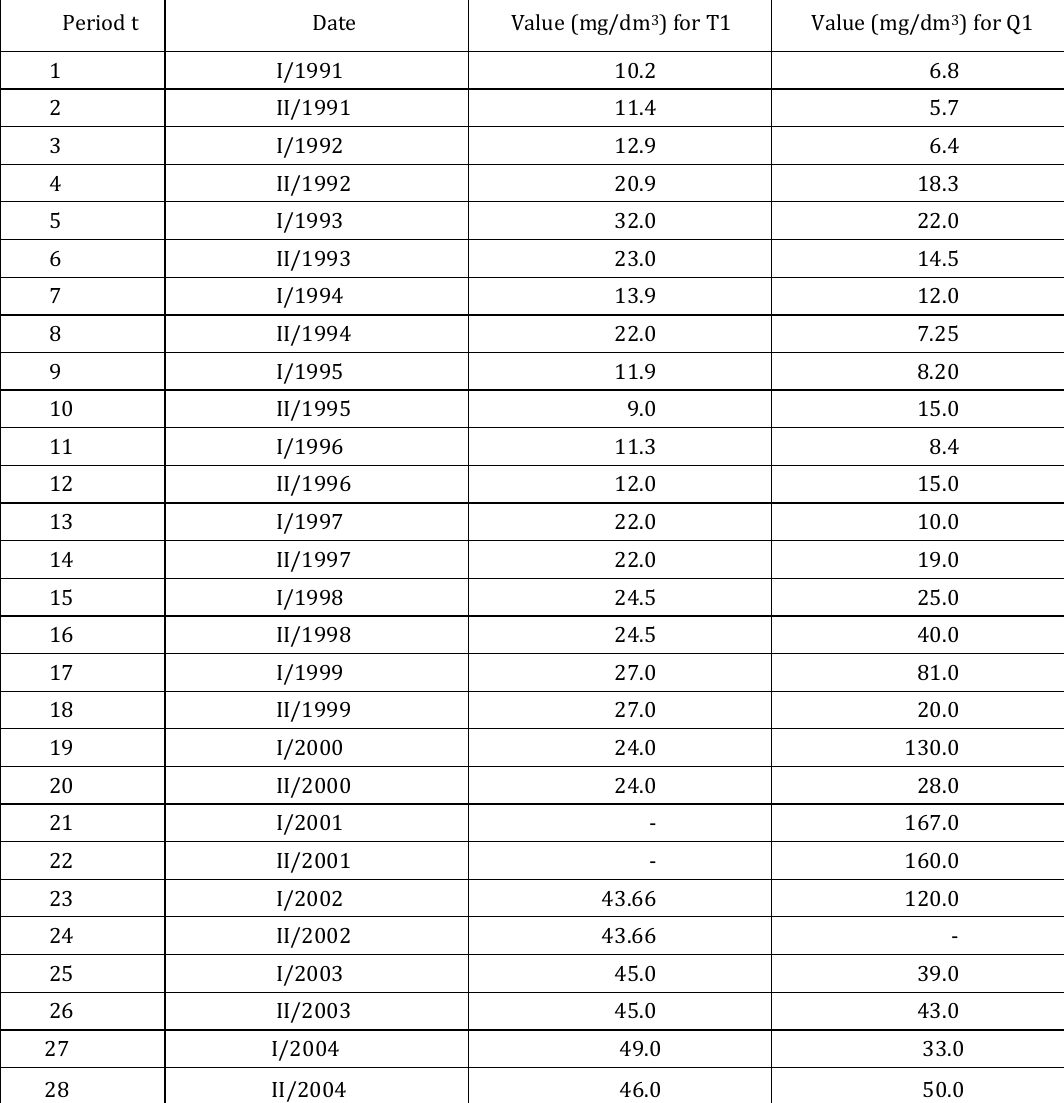
Table 1. Chloride concentration in piezometers T1 and Q1 in years 1991-2004 Period